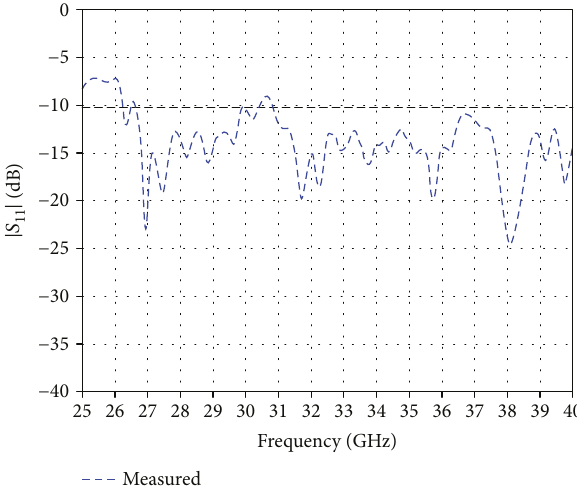
Figure 14: Measured S-parameters and mutual coupling of the 4 × 4 mmW array unit cell.